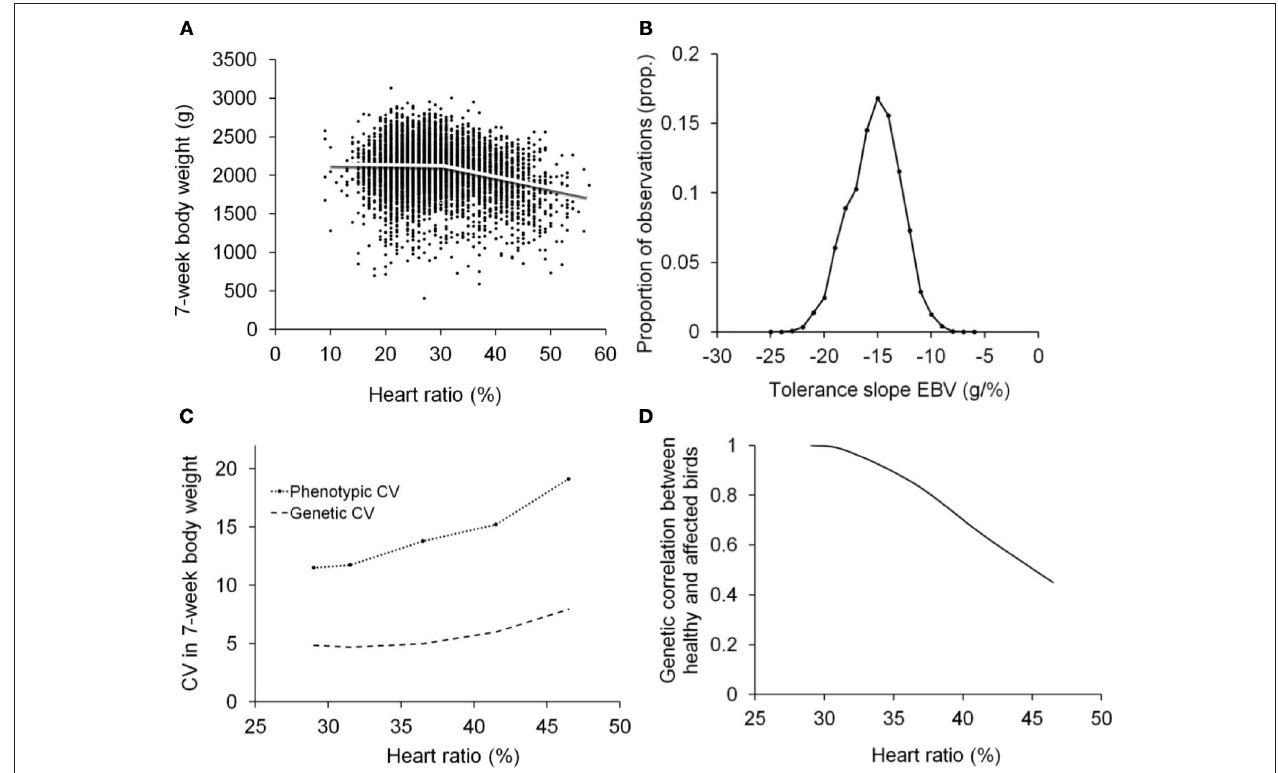
FIGURE 2 | Tolerance analysis using random regressions and covariance functions illustrated using data on 7-week body weight and heart ratio of broilers [reproduced from Kause et al. (2012); http://creative commons.org/licenses/by/3.0/]. Heart ratio, the ratio of right ventricular weight to total heart weight, is an indicator of ascites resistance, the birds with higher than 27–30% heart ratio typically being ascitic (Wideman et al., 1998). Tolerance is the change in body weight as a function of increasing ascites severity, measured as the hearth ratio. (A) Population average